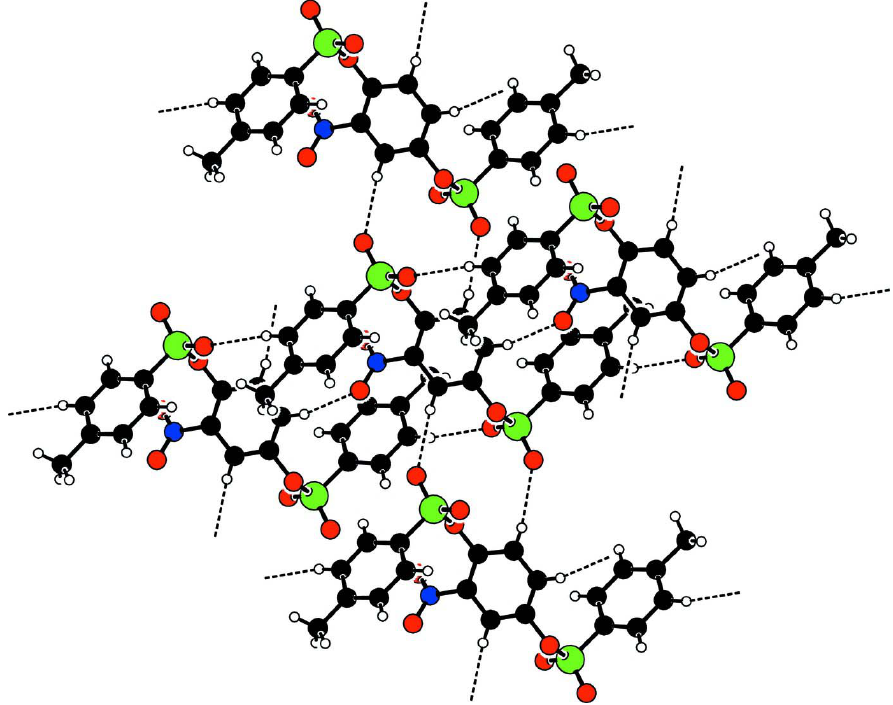
Figure 2 A packing diagram of the title compound. Hydrogen bonds are shown as dashed